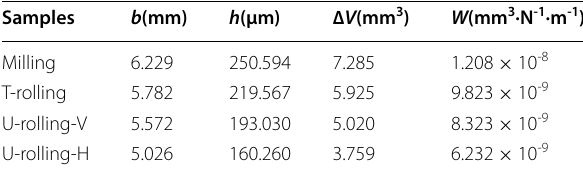
Table 7 Grinding pit size of laser cladding layer before and after